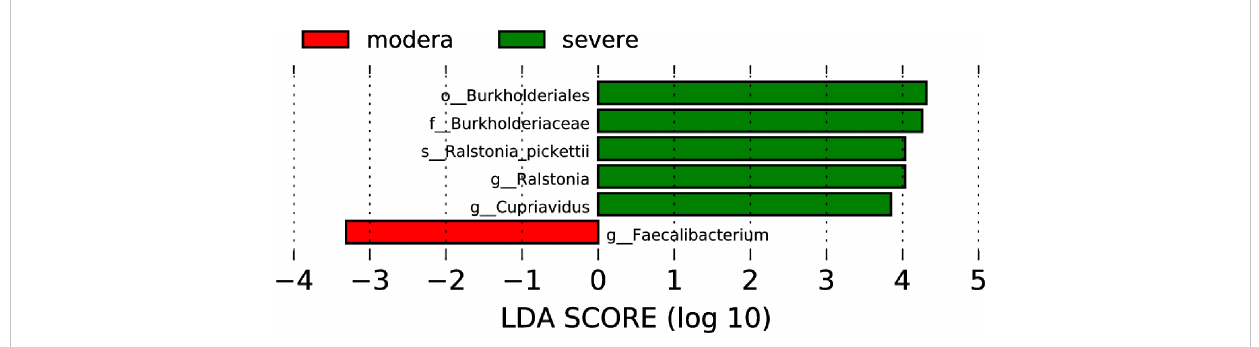
FIGURE 5 Nasal microbiological differences between moderate and severe patients.